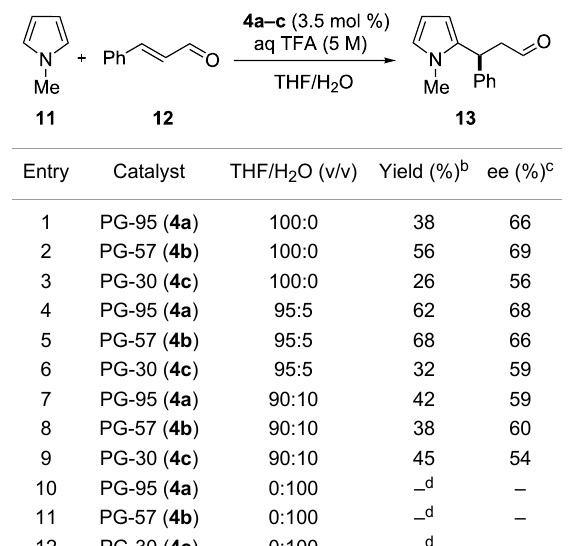
Table 1: Initial screening on the Friedel–Crafts alkylation of N -methylpyrrole ( 11 ) with trans -cinnamaldehyde ( 12 ). a